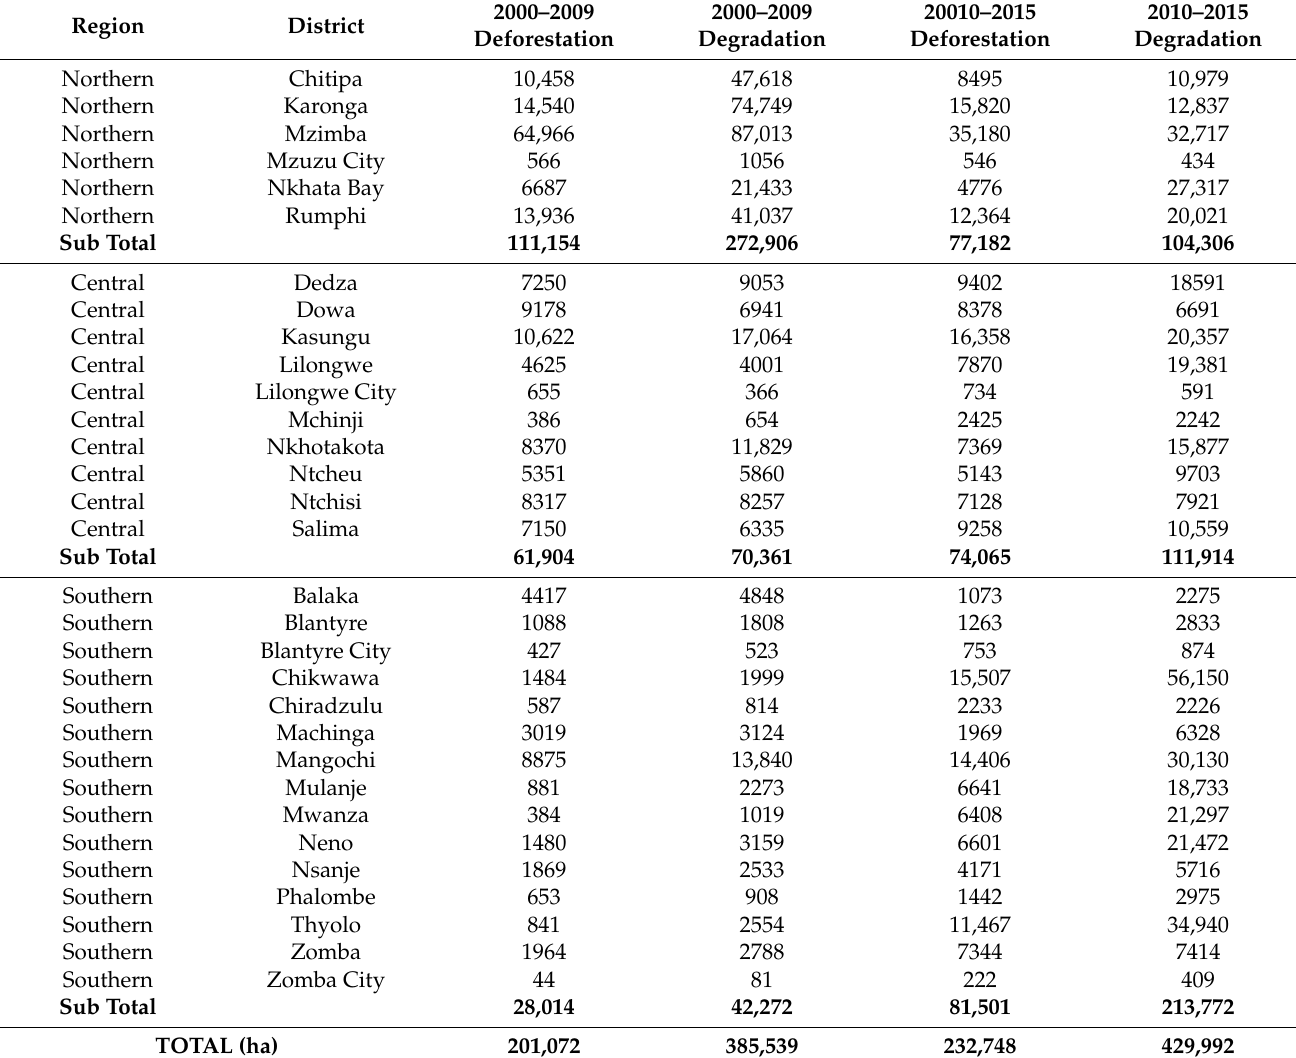
Table 4. Reporting of deforestation and forest degradation quantities by District